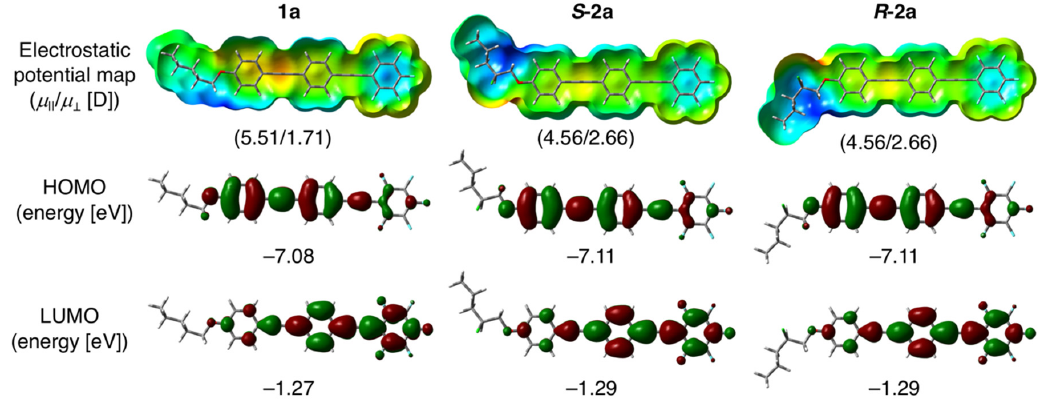
Figure 3. Electrostatic potential map, dipole moment ( µ ), HOMO diagram, and LUMO diagram for 1a , S -2a , and R -2a according to density functional theory (DFT) calculations performing using CAM-B3LYP/6-31+G(d) with the conductor-like polarizable continuum model (CPCM) model (CH 2 Cl 2 ).